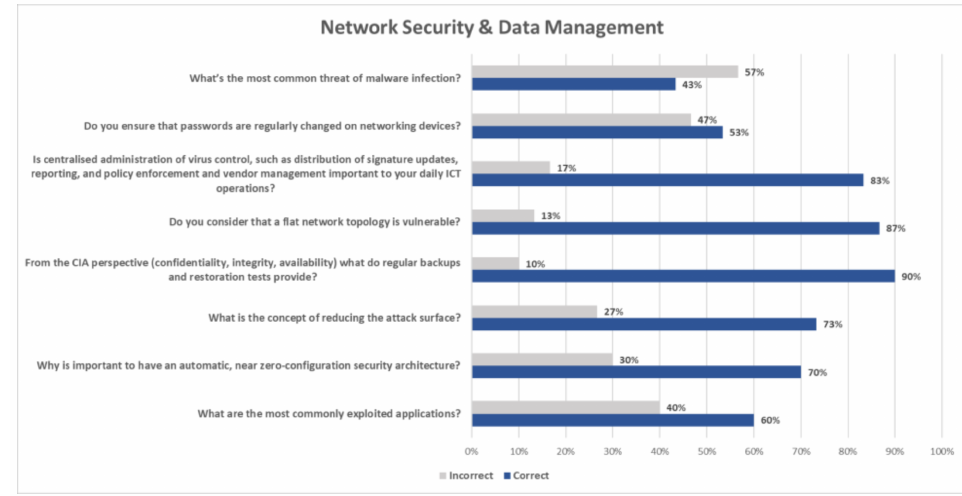
Figure 4. Evaluation of the Comprehension of Network Security and Data